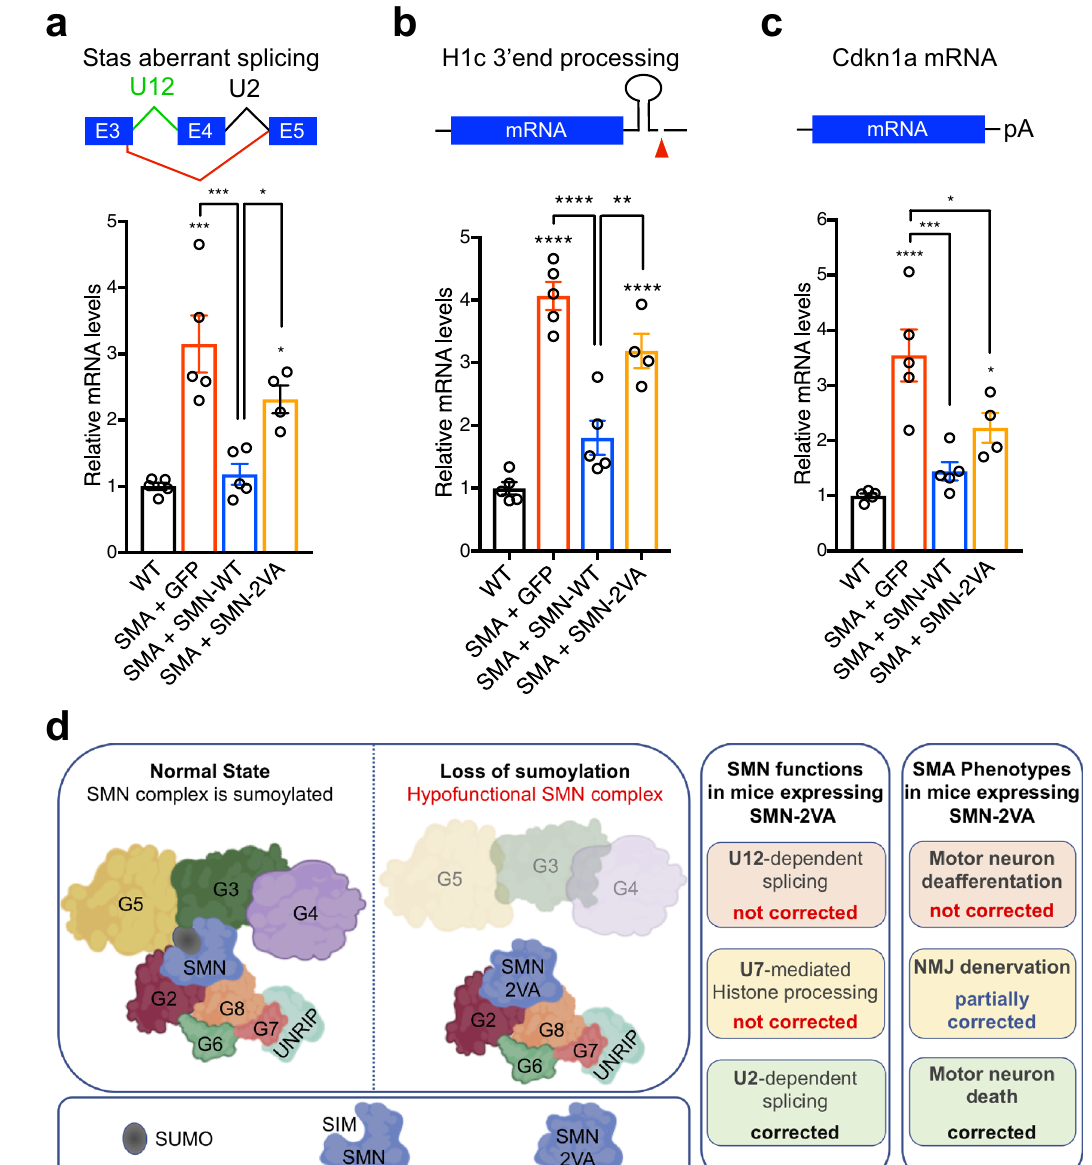
Fig. 9 SIM-less SMN fails to rescue select downstream RNA processing events disrupted by SMN de fi ciency in SMA mice. a RT-qPCR analysis of aberrantly spliced Stasimon ( Stas ) mRNA (indicated by the red lines between exon 3 and exon 5) in the spinal cord from WT mice or SMA mice injected with AAV9-GFP, AAV9-SMN-WT, or AAV9-SMN-2VA at P9. Data represent mean and SEM (WT n = 5 animals; SMA + GFP n = 5 animals; SMA + SMN-WT n = 5 animals; SMA + SMN-2VA n = 4 animals). Statistical signi fi cance was determined by one-way ANOVA with Tukey ’ s post hoc test (adjusted P